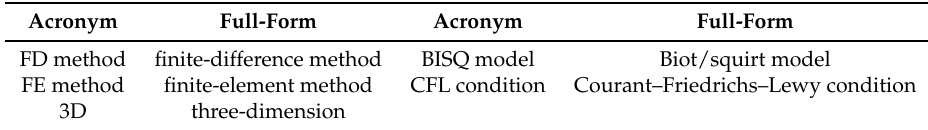
Table A2. Full-form of the